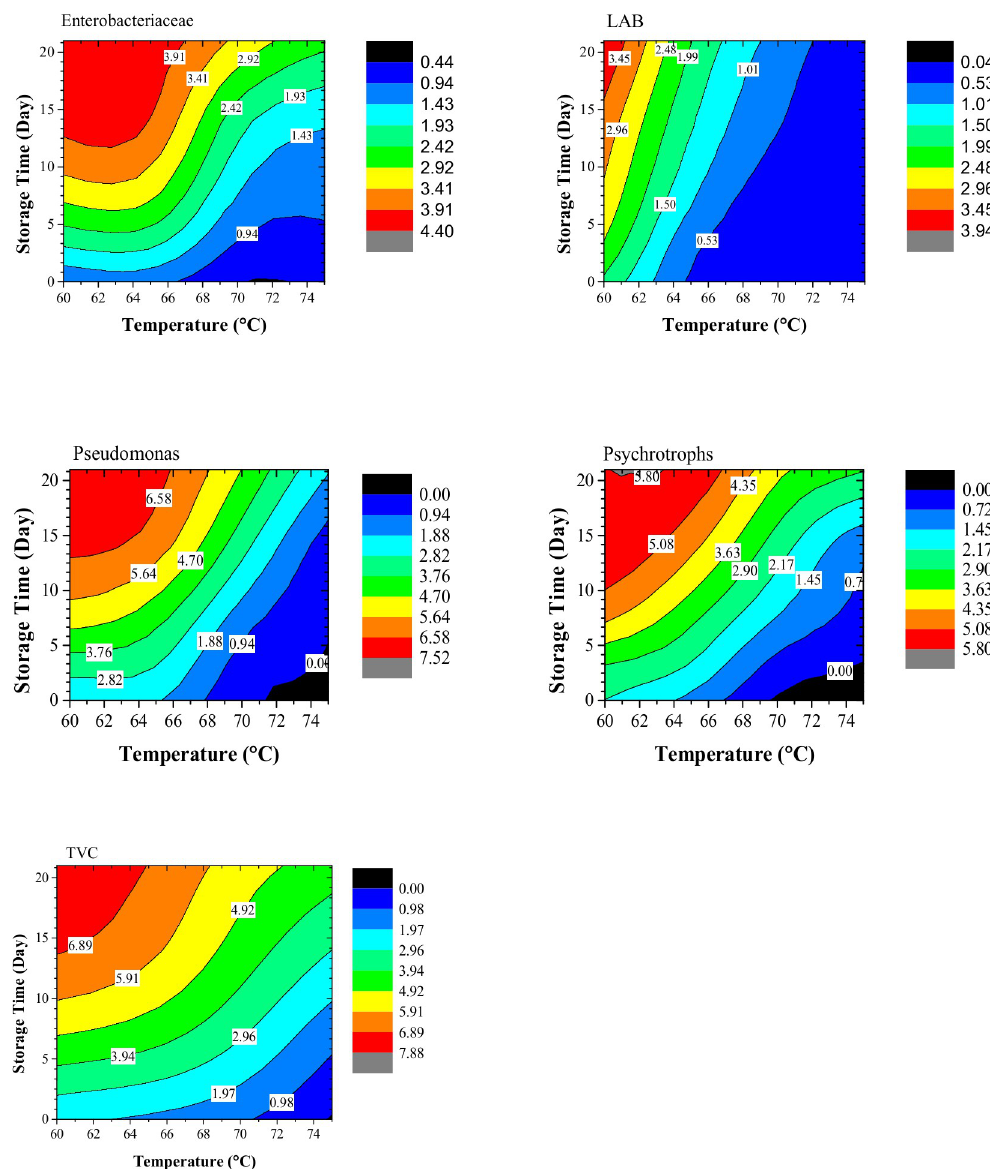
Fig 6. Simulated microbial count (Enterobacteriaceae, Lactic Acid bacteria (LAB), Pseudomonas, Psychrotrophs, and total viable count (TVC)) of sous-vide processed samples at different temperatures during cold storage.